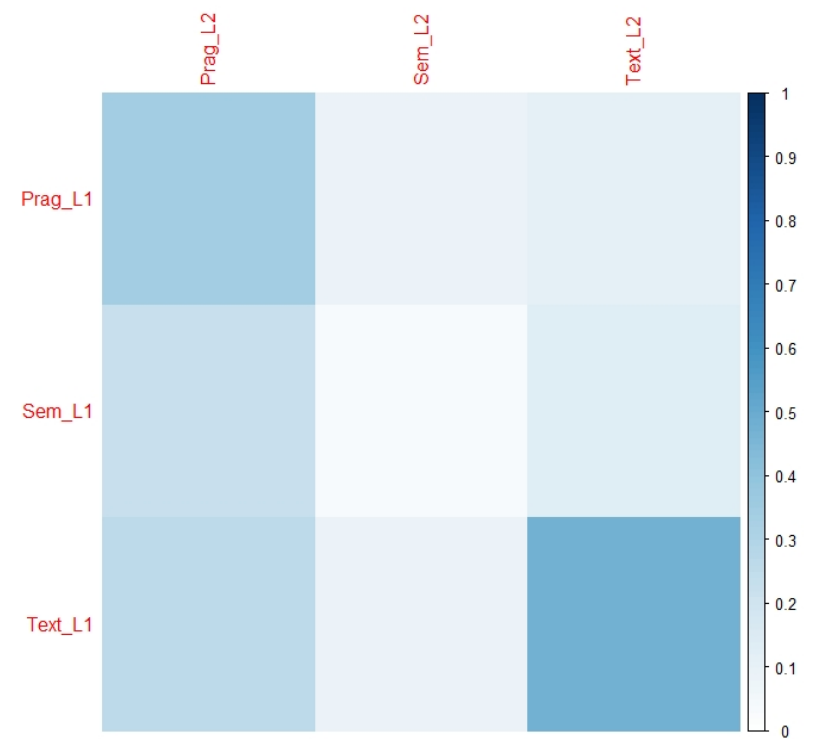
Figure 3. Correlations between subtests of the